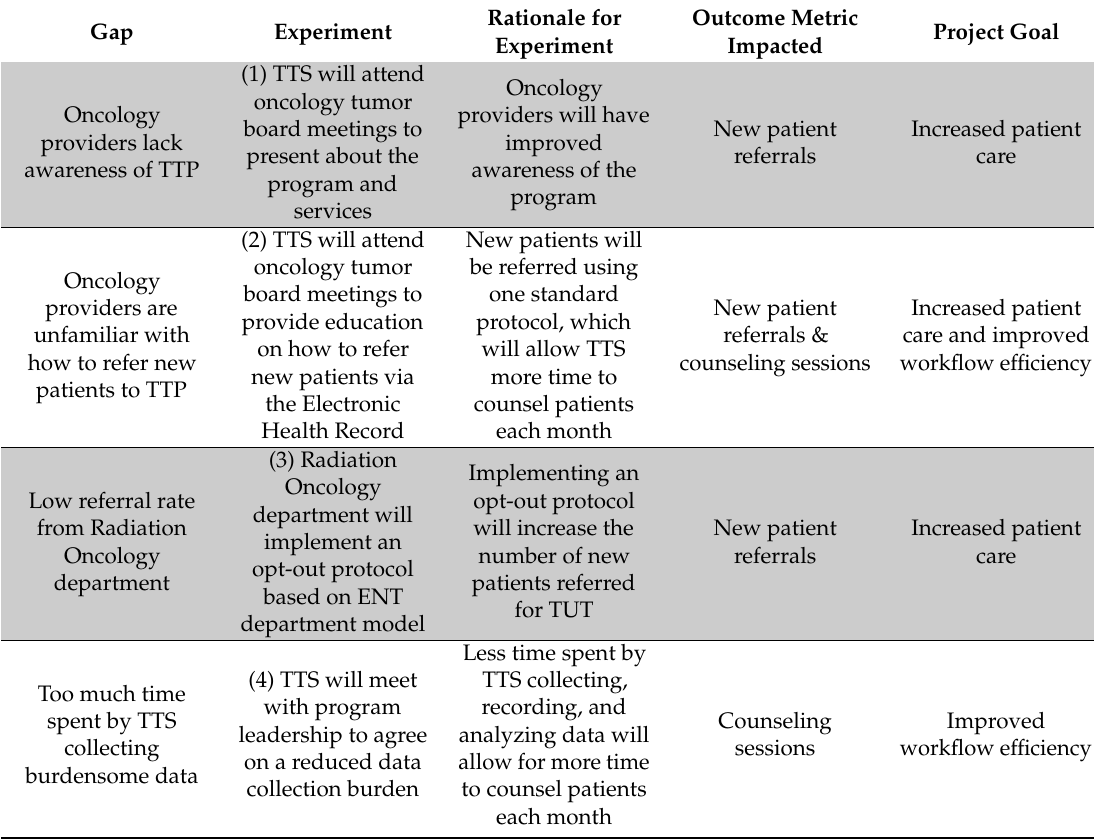
Table 1. Quality improvement experiments from gap analysis to project